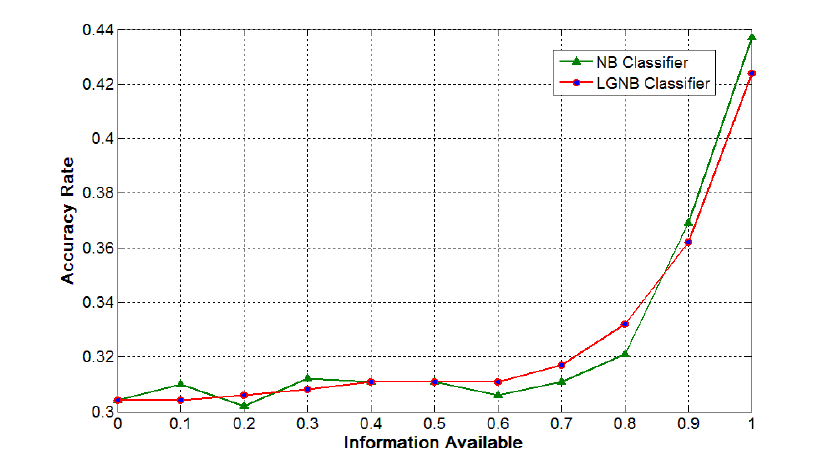
Fig. 4. Accuracy evaluation of LGNB